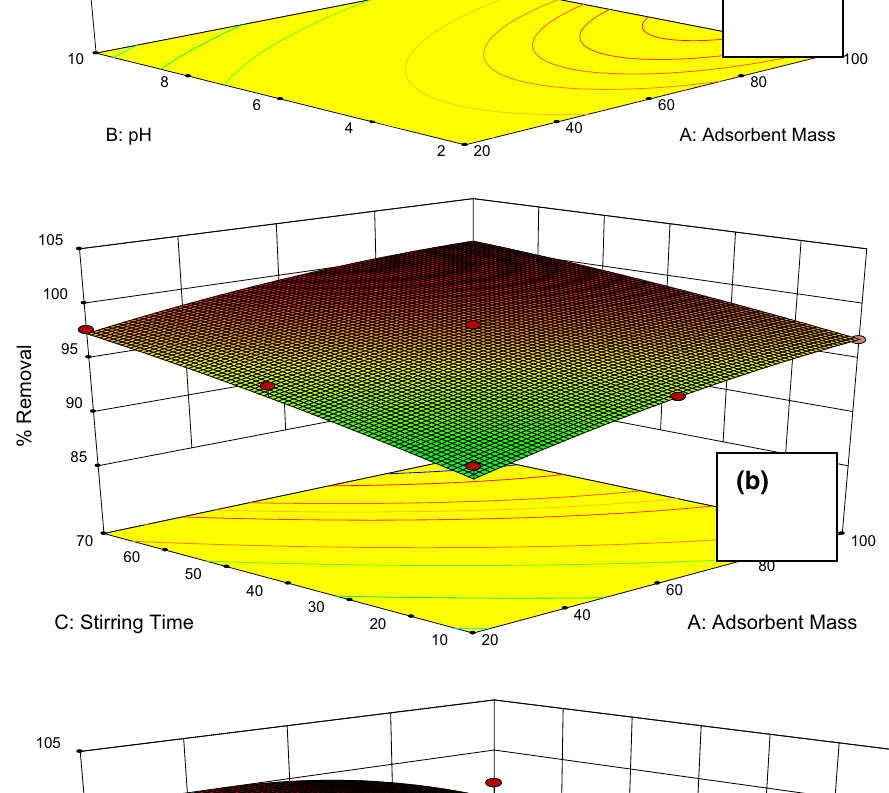
Fig. 16 Response surface plots of the effects of a pH vs adsorbent dosage, b contact time versus adsorbent dosage, c contact time vs pH for Pb(II) removal using OSA modified